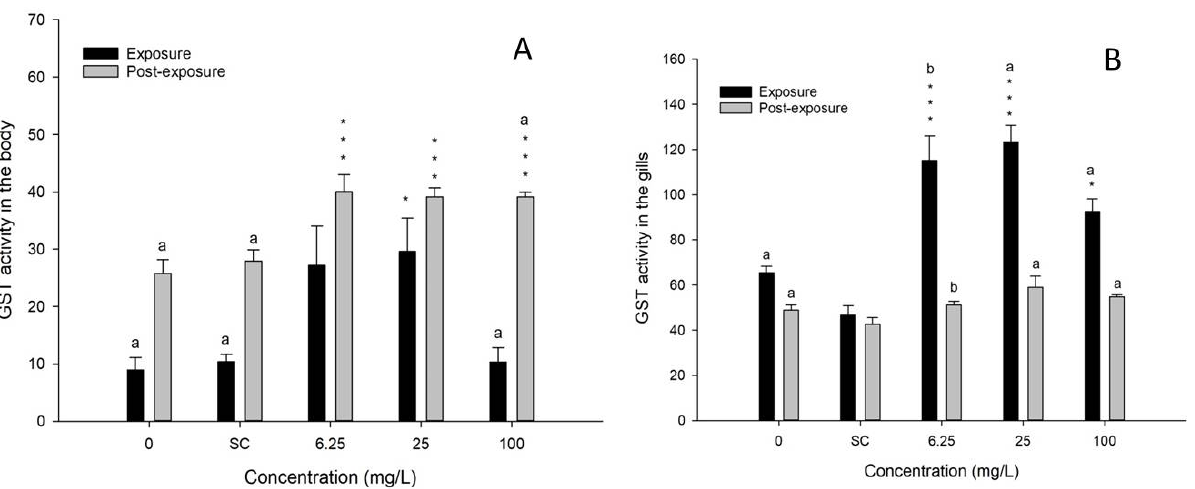
Figure 7 – GST A – activity in tail muscle (body) showing the results of exposure test and the recovery period of clearance. B – in gills showing the difference between exposure test and recovery period. * (P<0.05), *** P<0,001), a (P<0.001), b (P<0.01). a and b – comparing exposure with